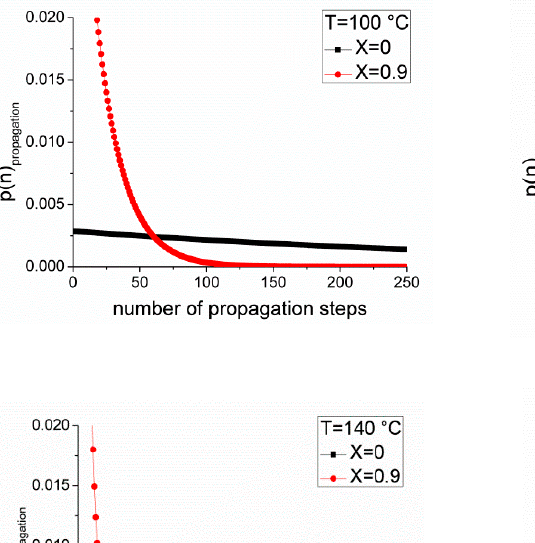
Figure S1: Molecular weight distribution from SEC-MALLS and the distribution transformed to give the number distribution for Sample 1, Figure S2: Simulated and experimental MALDI-TOF mass spectra of poly( n -BA) synthesized at 140 ◦ C in p- Xylene, Figure S3: Simulated and experimental MALDI-TOF mass spectra of the expanded region shown in the bottom figure which contains additional peaks of poly( n -BA) synthesized at 100 ◦ C in p- Xylene (reaction 2 in Table 1), Figure S4: MALDI-TOF mass spectra (left) and number distribution calculated from raw data (right) for poly(butyl acrylate) obtained by solution polymerization at 60 ◦ C, 100 ◦ C or 140 ◦ C and at 20 wt % or 30 wt % in p- Xylene, Figure S5: Simulated MALDI-TOF spectra with high rates of macromonomer propagation and β -scission at 140 ◦ C at [ M ] = 30 wt %, Scheme S1: Radical migration steps starting from the initial tertiary radical position in close proximity to the end chain, Figure S6: Comparison of mid-chain radical distribution function based on analytical equation (lines) or kinetic Monte-Carlo simulation (symbols) for T = 140 ◦ C , Figure S7: Comparison of mid-chain radical distribution function based on analytical equation (lines) or kinetic Monte-Carlo simulation (symbols) for T = 140 ◦ C, Figure S8: Comparison of mid-chain radical distribution function based on analytical equation (lines) or kinetic Monte-Carlo simulation (symbols) for T = 140 ◦ C, Figure S9: Simulated peak maximum for the B-H species as a function of the rate coefficient of k mig for experiment 4 ( T = 140 ◦ C at [ M ] = 30 wt %, squares) and experiment 3 ( T = 140 ◦ C at [ M ] = 30 wt %,